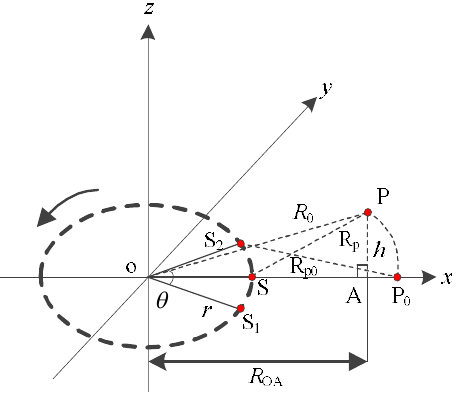
Figure 2. Target P and its imaging result on the reference plane.